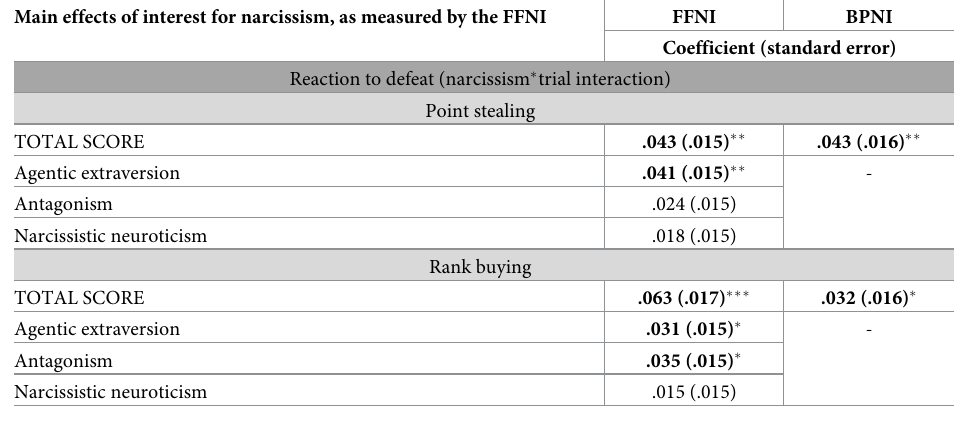
FFNI, Five-Factor Narcissism Inventory; BPNI, Brief Pathological Narcissism Inventory � , p < .05 �� , p < .01 ��� , p <